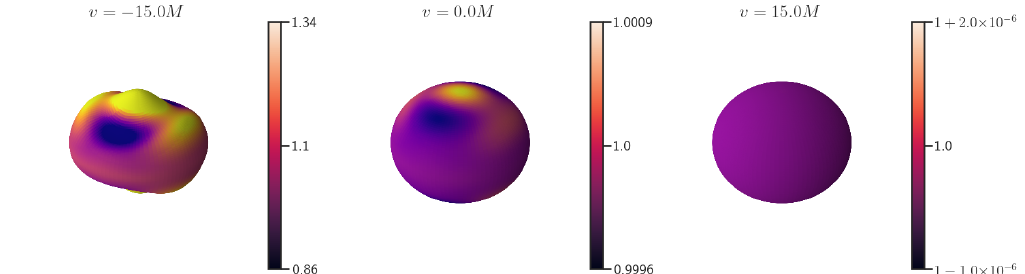
Figure 11 . Isometric embedding diagram of the induced metric in the horizon at different times. The colormap represents the radius of the embedding sphere (normalized). Short wavelength per- turbations become relevant at early